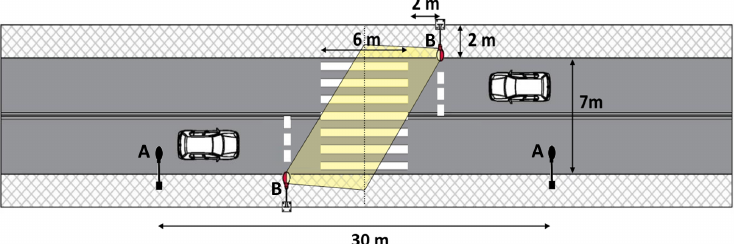
Figure 1. The reference lighting situation in a pedestrian crossing: A —streetlights; B —dedicated pedestrian crossing